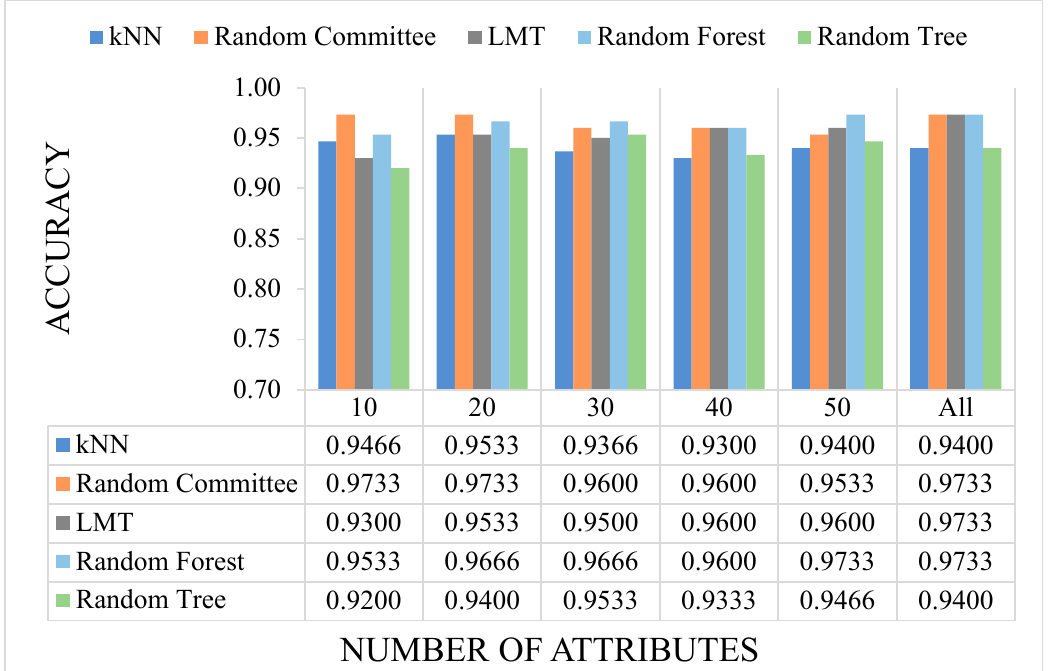
Figure 7 . The accuracy results of the ML models on cancer prediction with different numbers of attributes. (Illustrations by the authors) .